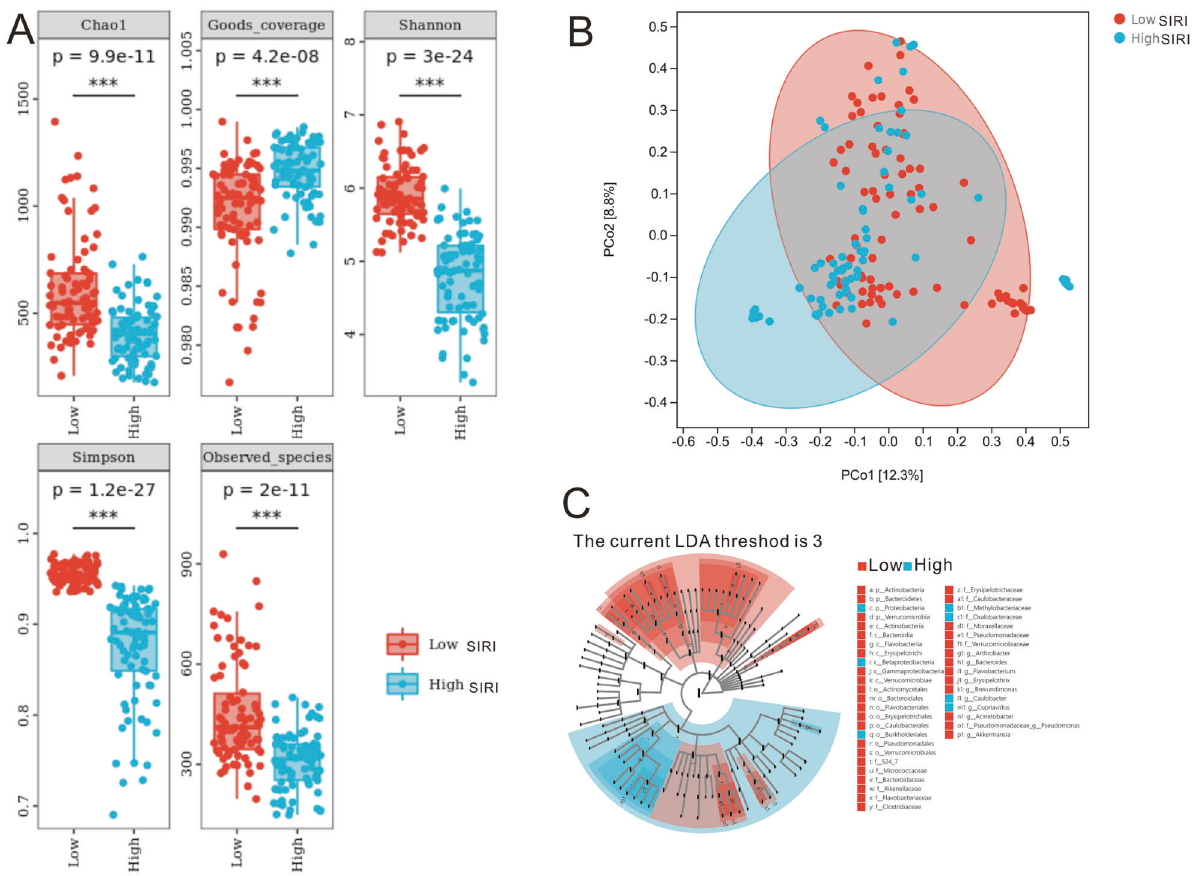
Fig. 4 Diversity of microbiota and LEfSe analyses of the low and high SIRI groups. A Alpha diversity reveals that species richness was different between the two groups. B Beta diversity analysis revealed by PCoA. C LEfSe analysis revealed that there was a remarkable difference in species diversity between the two functional pathways. The top 5 pathways of biosynthesis were amino acid biosynthesis; cofactor, prosthetic group, electron carrier, vitamin biosynthesis; nucleoside and nucleotide biosynthesis; fatty acid and lipid biosynthesis, and carbohydrate biosynthesis. In